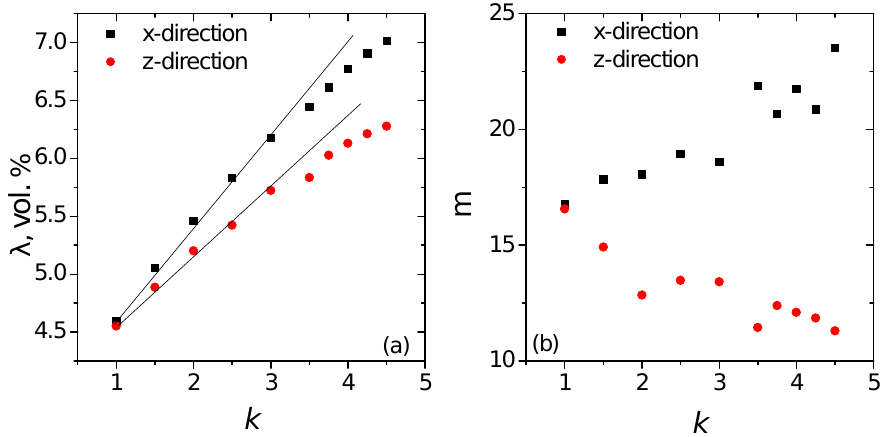
Figure 4. Scale factor ( a ) and Weibull modulus ( b ) as a functions of the